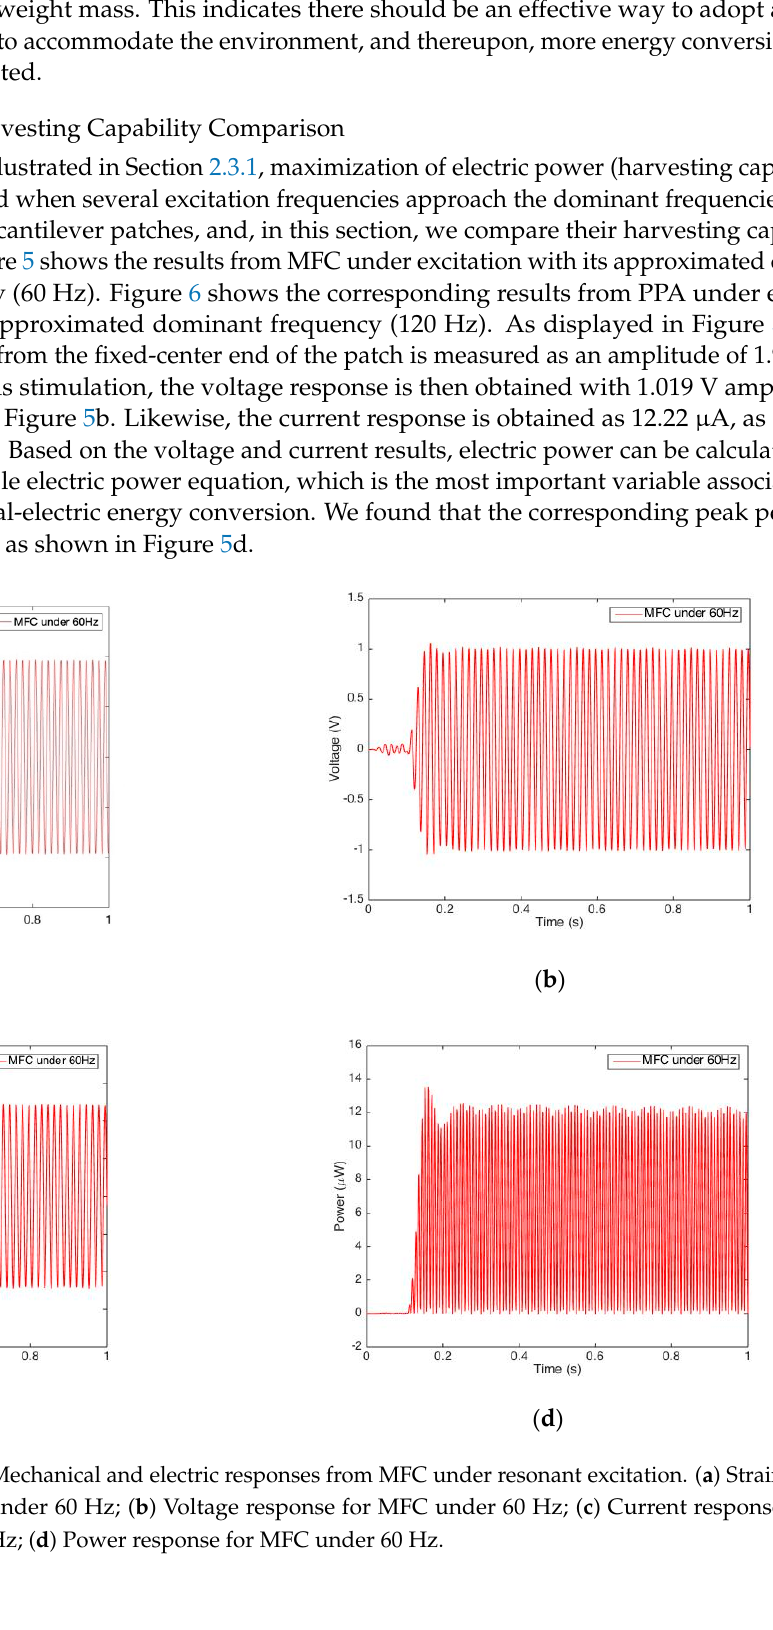
( d ) Figure 6. Mechanical and electric responses from PPA under resonant excitation. ( a ) Strain response for PPA under 120 Hz; ( b ) Voltage response for PPA under 120 Hz; ( c ) Current response for PPA under 120 Hz; ( d ) Power response for PPA under 120 Hz. Likewise, Figure 6 shows the results from PPA under it dominant frequency excita- tion (120 Hz). As illustrated in Figure 6b–d, we found the responses’ amplitudes of strain,